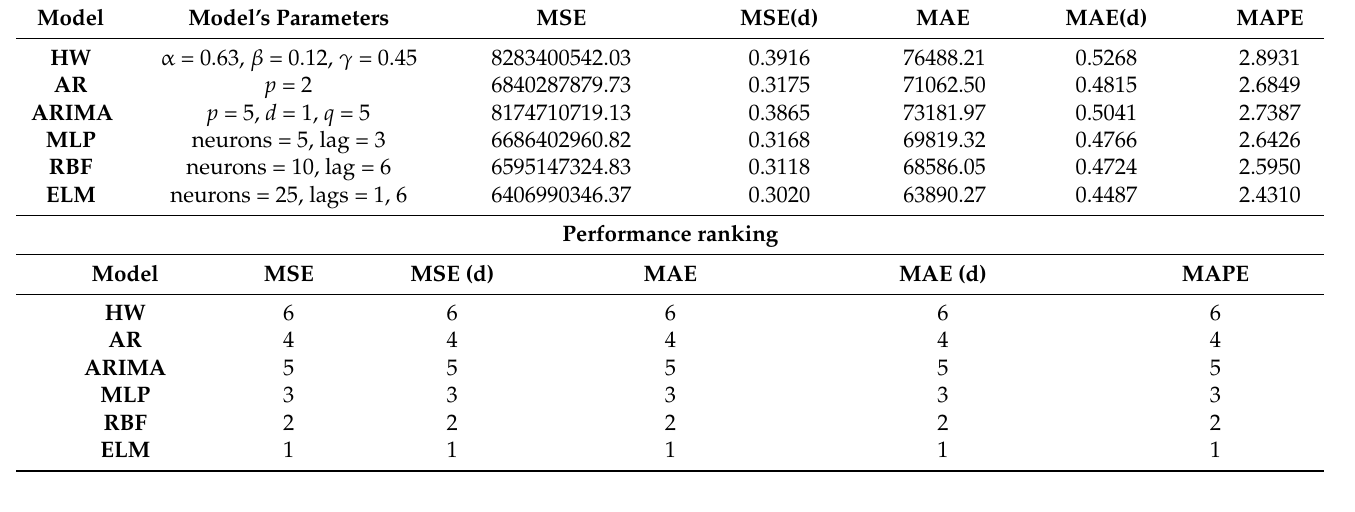
Table 7. Forecast results for six steps ahead, compared by the error measures MSE, MAE, MAPE, and their respective performance rankings.